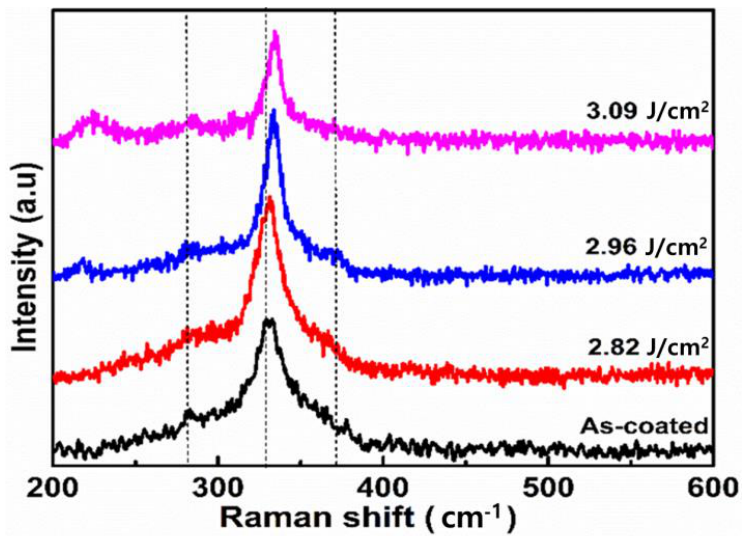
Figure 5. Raman spectrum of photo-sintered CZTS thin films on molybdenum glass substrate.